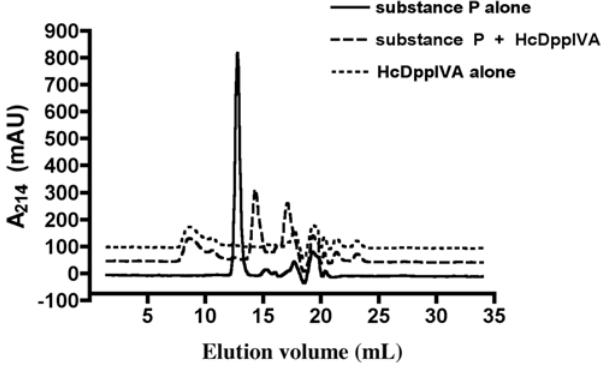
Figure 3. Chromatogram showing substance P truncation by HcDppIVA. 50 m g substance P was incubated with or without 5 mU recombinant HcDppIVA. Solid line: undigested substance P; heavy dotted line: substance P + HcDppIVA, light dotted line: purified HcDppIVA alone. Elution volumes for truncated substance P products correspond to those of CD26-mediated truncation (data not shown).